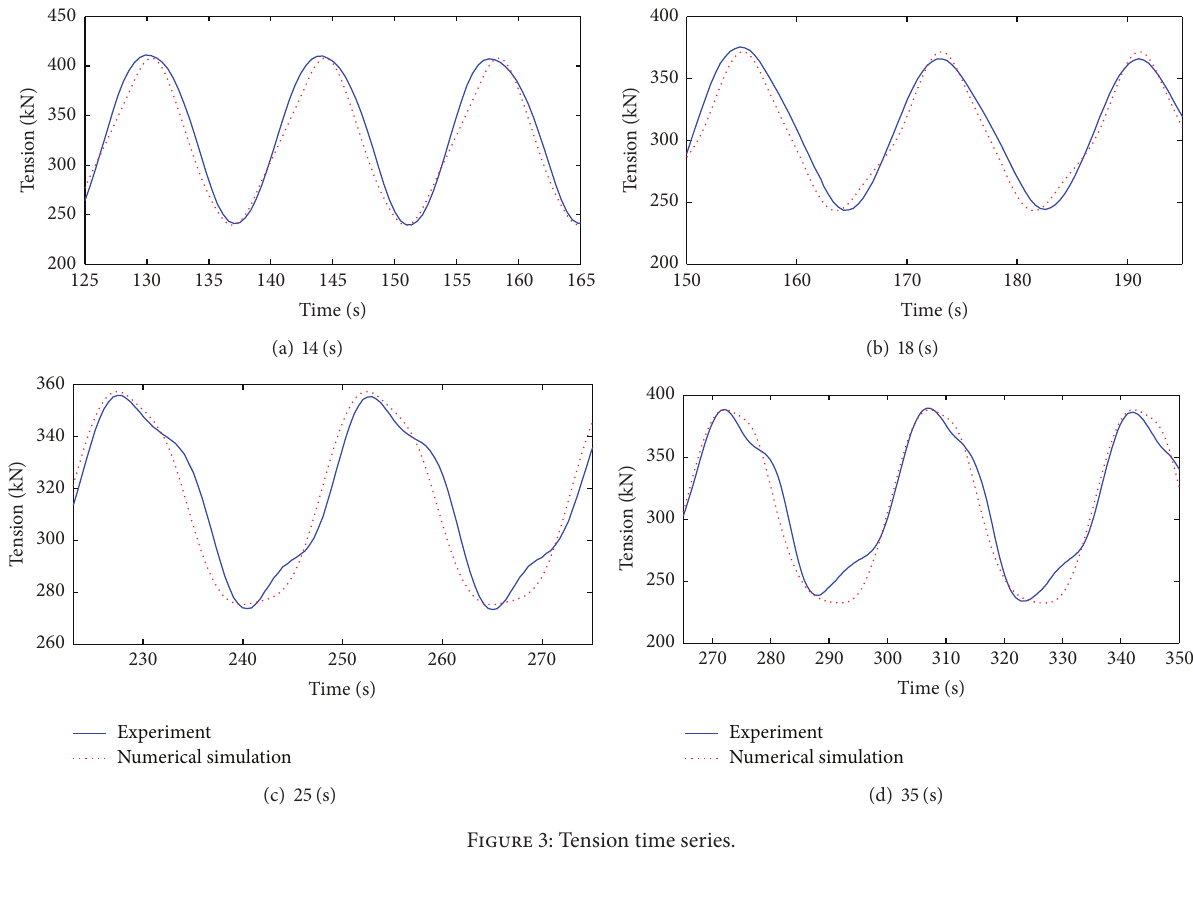
Figure 3: Tension time series.